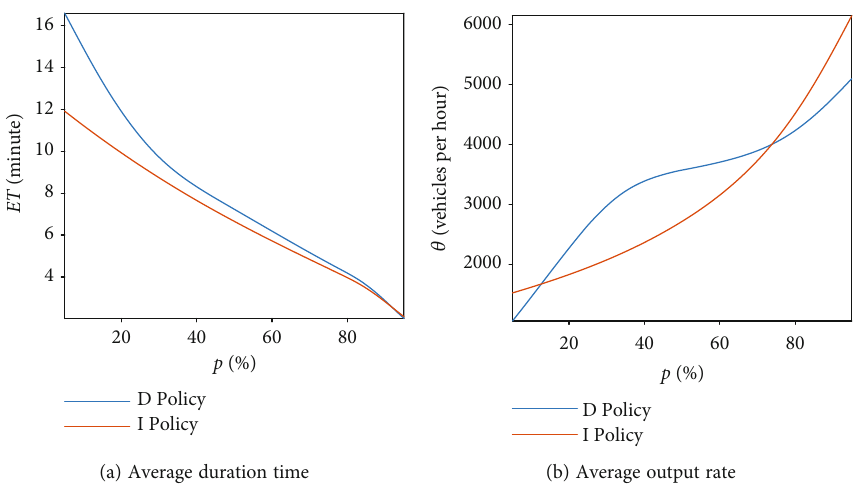
Figure 10: Comparison between the D policy and the I policy when SCV = 1 under a high tra ffi c